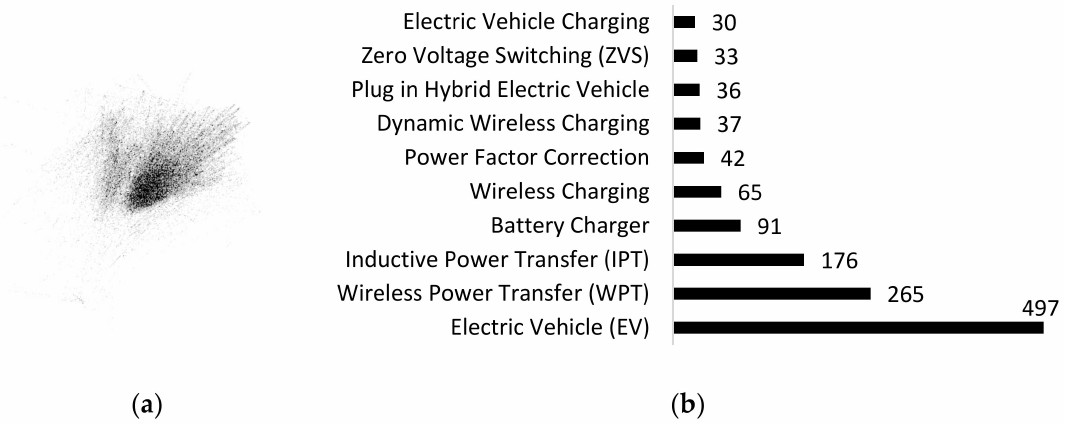
Figure 6. Representation of the Battery Chargers community: ( a ) Isolated distribution of publications; ( b )